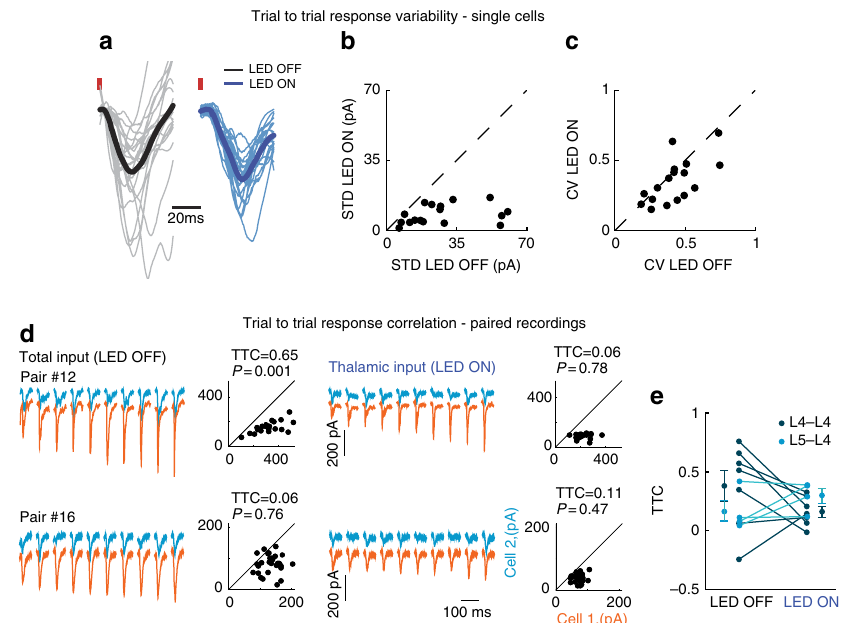
Figure 4 | Sensory-evoked noise correlations are not determined by thalamic inputs. ( a ) Example of all the responses of a representative L4 cell to whisker stimulation under LED OFF (grey traces with black trace for the mean) and under LED ON (blue traces with mean as dark blue) in anaesthetized animal. Data were normalized to the mean of each condition. ( b ) Population data of the standard deviation of the peak response measured for each trial at the two conditions. ( c ) Same as b for the coefficient of variation (CV). ( d ) TTC EE measurements during LED OFF (left) and LED ON trials (right). Responses to 10 sequential whisker stimuli of one cell (orange traces) sorted from the smallest to the largest amplitude with the corresponding responses of the second cell (blue traces). Scatter plots show peak excitatory current responses of one cell plotted against that of the second cell. ( e ) Population data and averaged TTC EE for LED OFF and LED ON conditions in L4–L4 pairs (mean TTC EE ¼ 0.38 ± 0.14 and 0.16 ± 0.05, respectively, P ¼ 0.219 Wilcoxon signed- rank test, n ¼ 7) and in mixed L4–L5 pairs (mean TTC EE ¼ 0.16 ± 0.09 and 0.29 ± 0.06, P ¼ 0.375, Wilcoxon signed-rank test n ¼ 4). TTC across the two conditions did not show significant correlation ( r 2 ¼ 0.07, P ¼ 0.557 and r 2 ¼ 0.16, P ¼ 0.596 for L4–L4 and L4–L5 pairs,